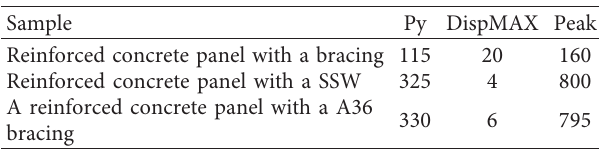
Figure 11: Hysteresis diagram of the reinforced concrete panel with a SSW. Table 3: Test results.